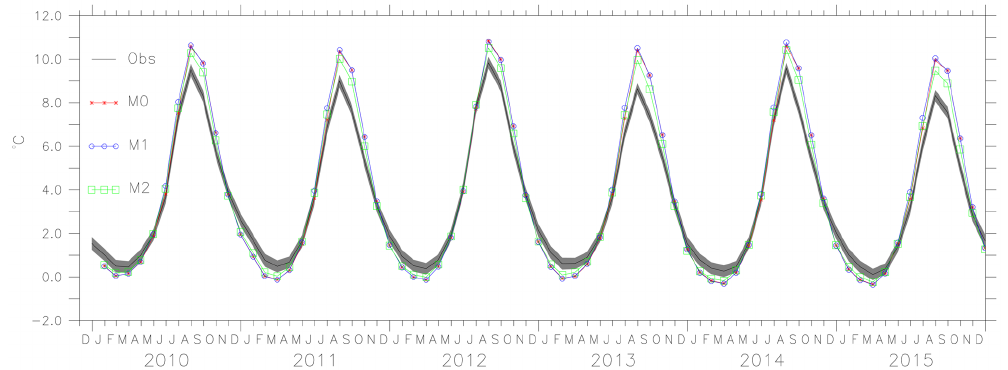
Figure 13. The SST from AVHRR-only OISST analysis with the shaded region represents the uncertainty in AVHRR-only OISST analysis and SST from models M0, M1 and